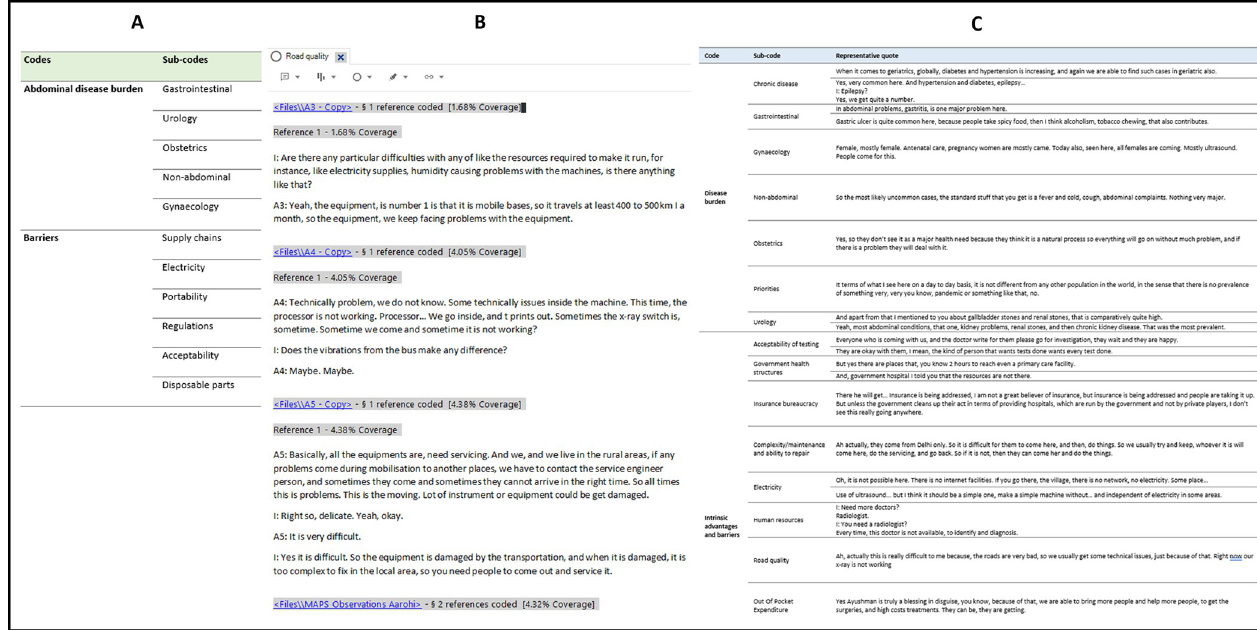
Fig 1. An illustration of sections of the a-priori codex, the coding process in N-vivo, and sections of the charting process. A–An example of the a-priori coding schedule; B–An example of the coding process in Nvivo–version 11; C–An example of the final coding schedule with quote examples.